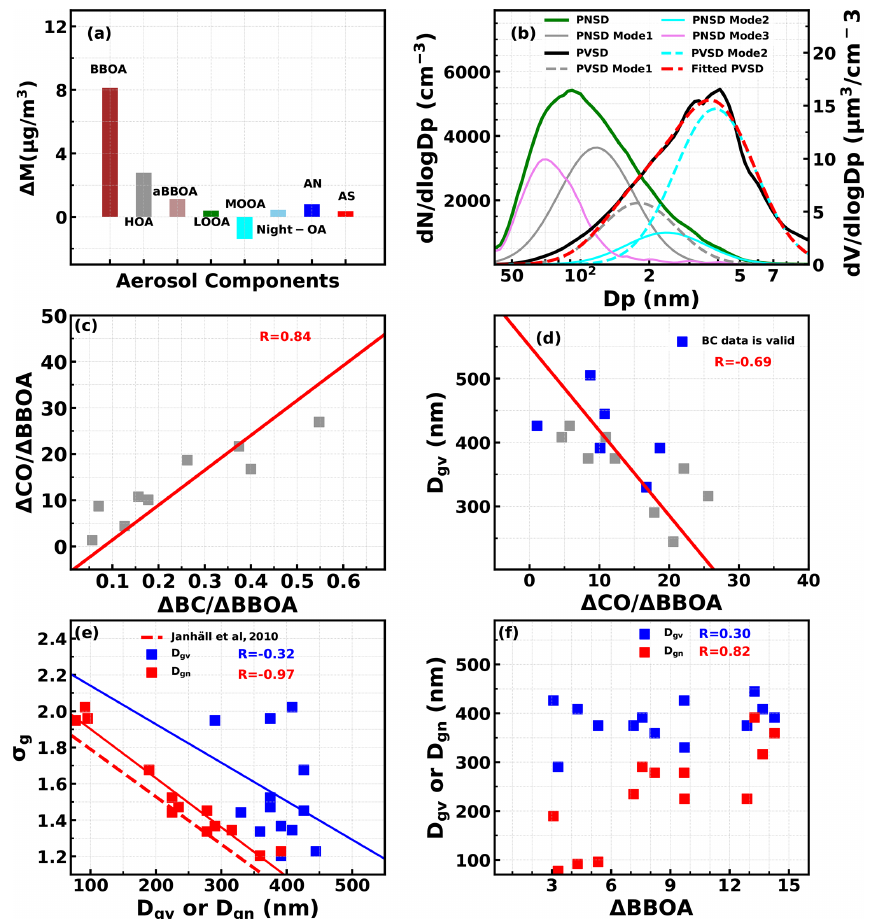
Figure 3. (a) Average differences of aerosol components before and after BBOA spikes. (b) Corresponding particle average number and volume size distribution difference ( (cid:49) PNSD and (cid:49) PVSD). (c) Relationship between (cid:49) CO /(cid:49) BBOA and (cid:49) BC /(cid:49) BBOA. (d) The relation- ships between identified D gv of BBOA spikes and corresponding (cid:49) CO /(cid:49) BBOA (ppb(ugm − 3 ) − 1 ). (e) Relationship between retrieved D gv and σ g , as well as D gv and σ g . (f) Relationships between D gv or D gn and (cid:49)